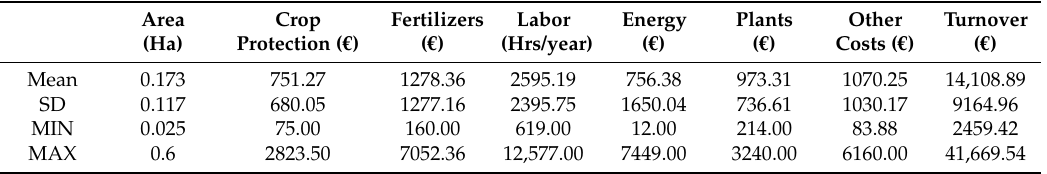
Table 3. Descriptive Statistics.